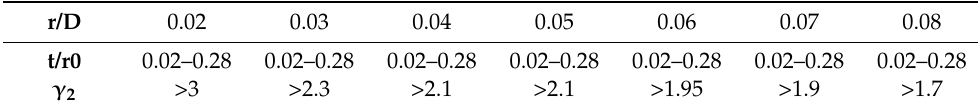
Table 7. Ranges of pressure coefficient at the fold stage for a/2 h = 0.8–1.2.